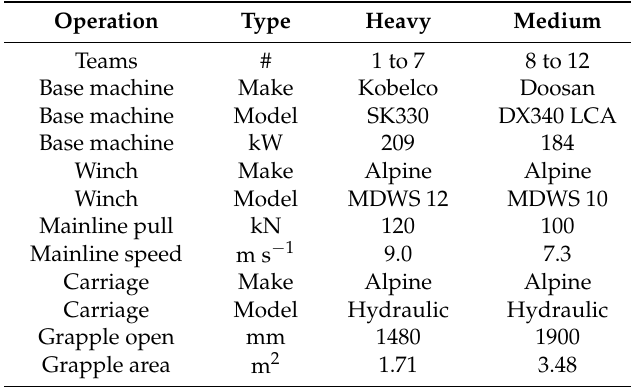
Table 1. Main characteristics of the excavator-based un-guyed yarders on test. Operation